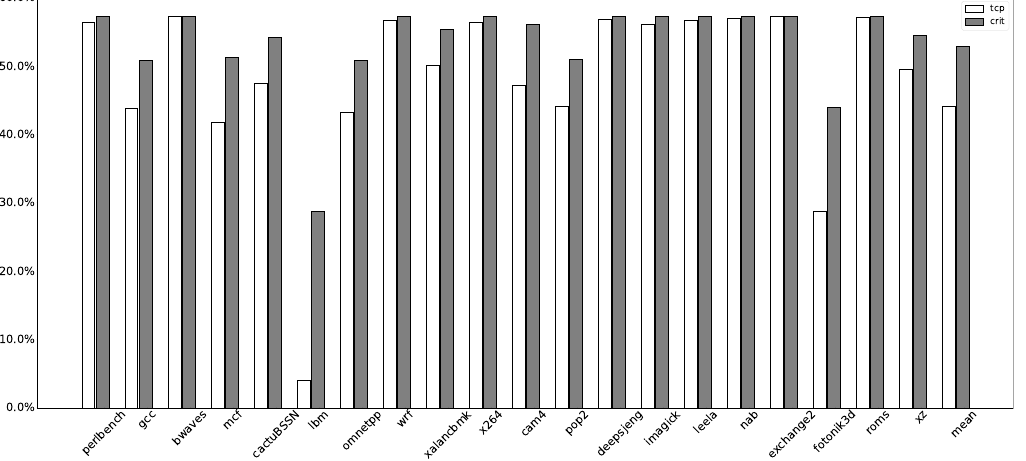
Figure 10. Comparison of proportion of dynamic